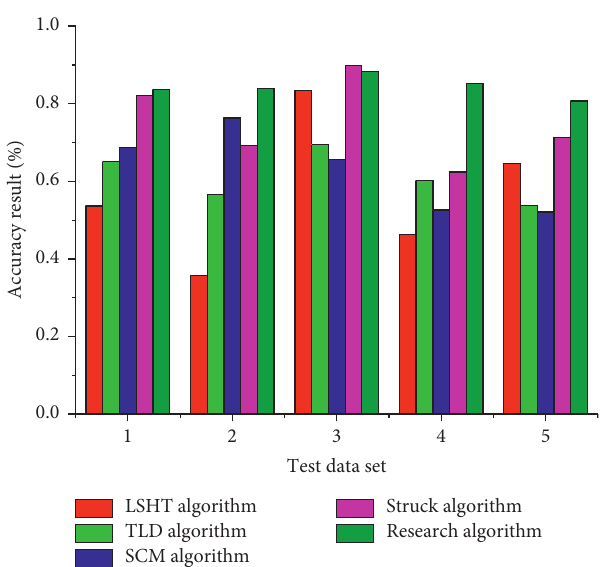
Figure 4: Accuracy results of each algorithm in the masking sequence.